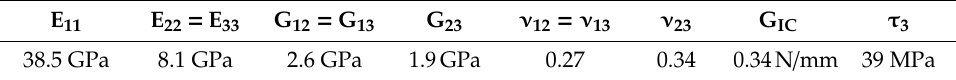
Table 2. Mechanical and interface material properties of GFRP material